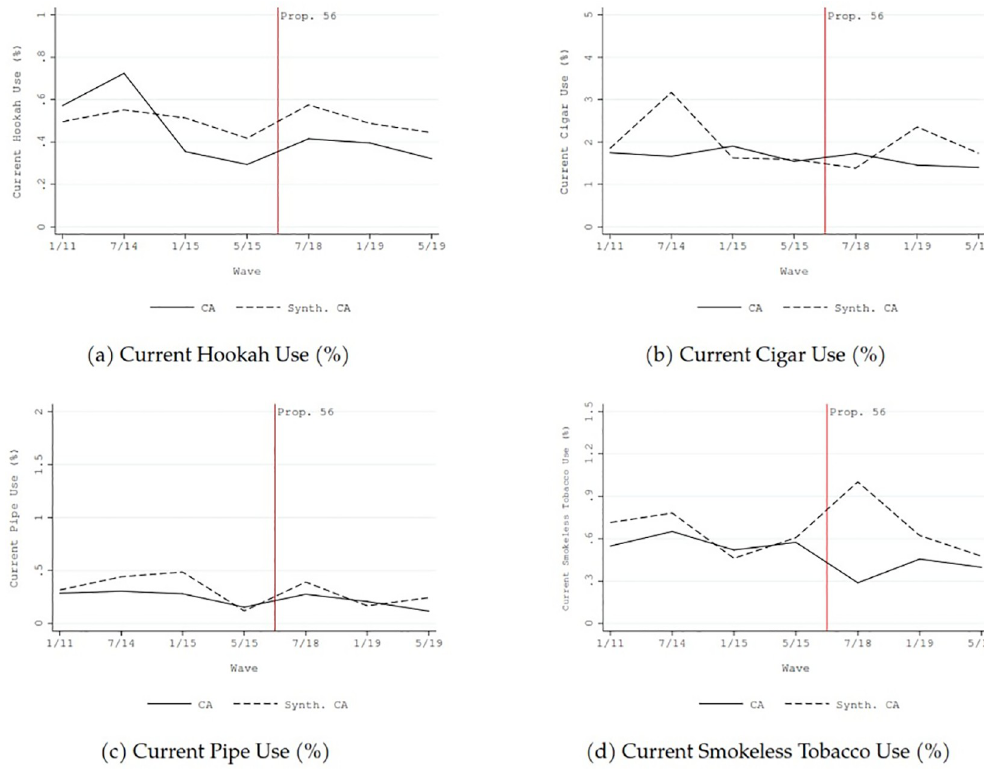
Fig 3. Comparison before and after the implementation of California Proposition 56 tobacco tax increase between California and synthetic control: Non-cigarette tobacco use outcomes—current use (%).